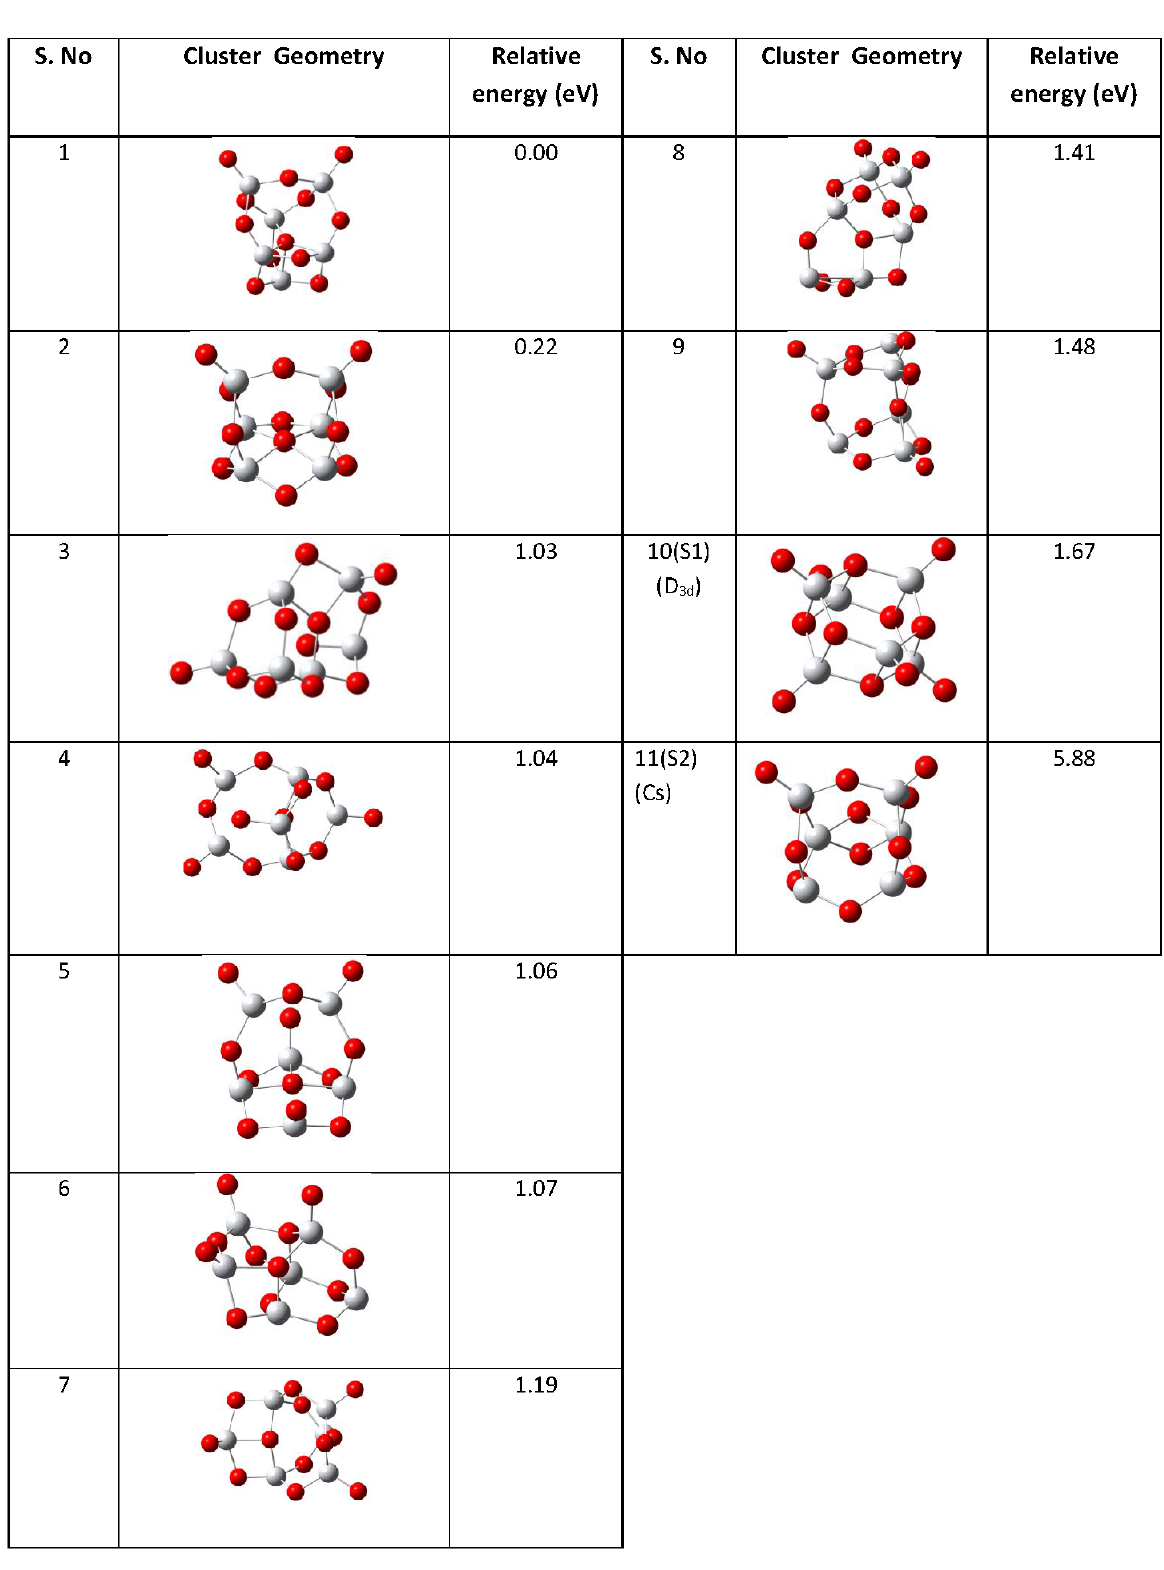
Figure 1. Optimized geometries of isomeric forms of (TiO 2 ) 6 cluster in gas phase. Red spheres represent oxygen and grey spheres represent titanium atoms,